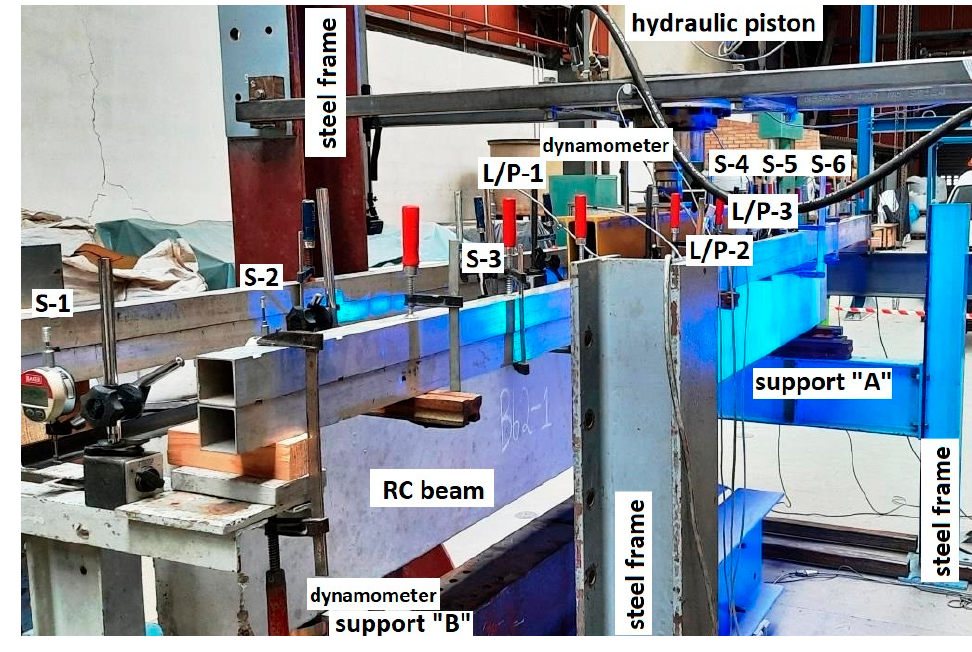
Figure 6. General view of the test stand.